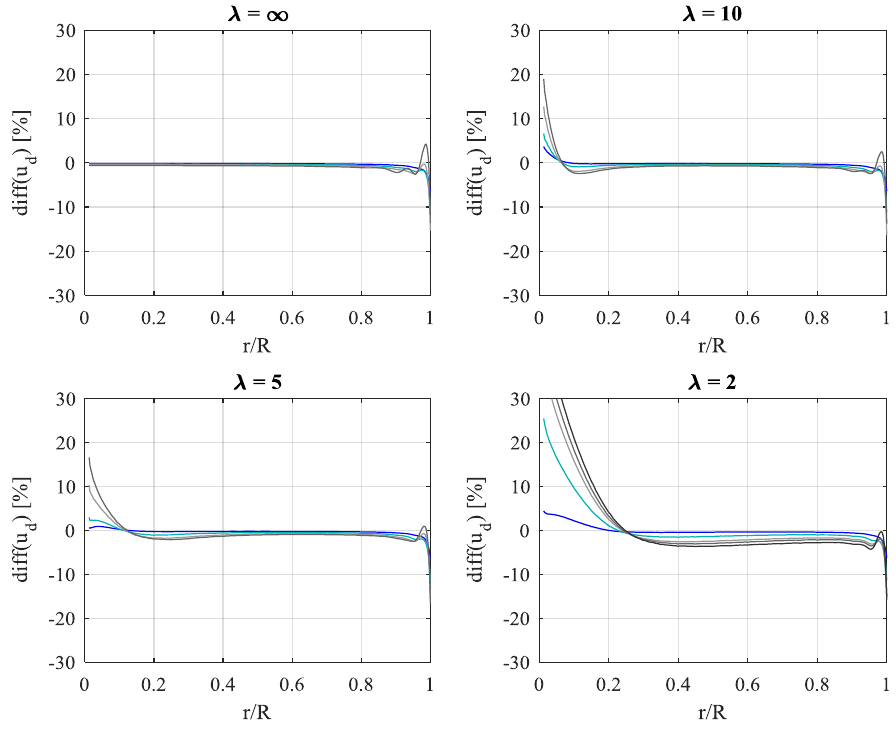
Figure 7. BEM-E results compared to AD.